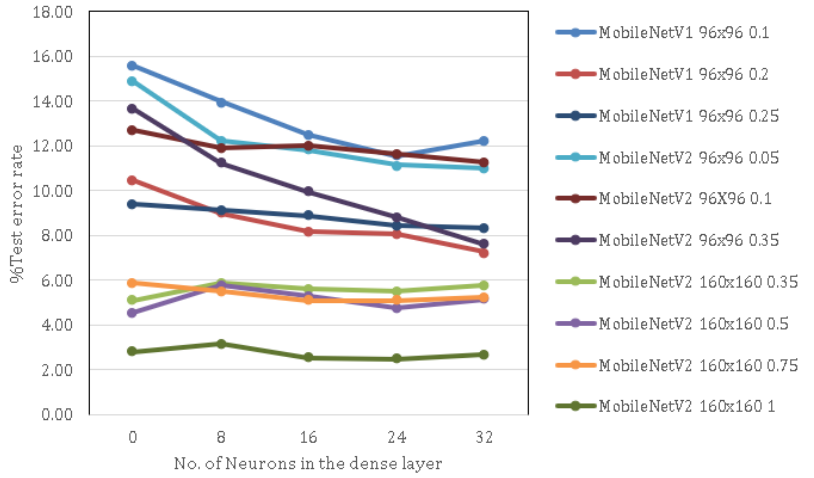
Figure 7. Effect of the number of neurons in the dense layer on model performance for the tested MobileNet